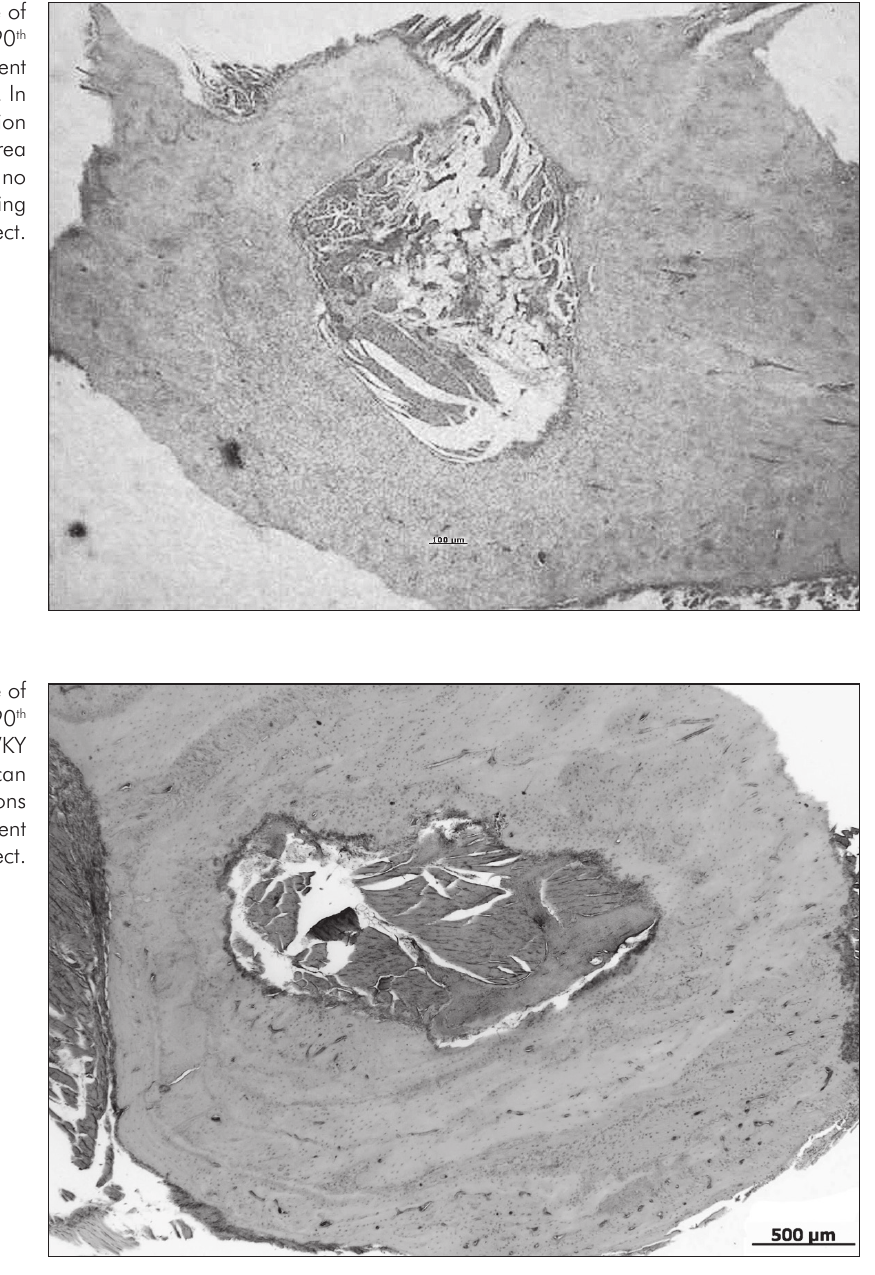
Figure 2 - Histological image of the entire 5 mm defect at the 90 th postoperative day, showing evident deformation around the defect area. In this SHR specimen, evident deformation can be seen around the defect area without complete closure. There are no signs of bone neoformation, suggesting a permanent